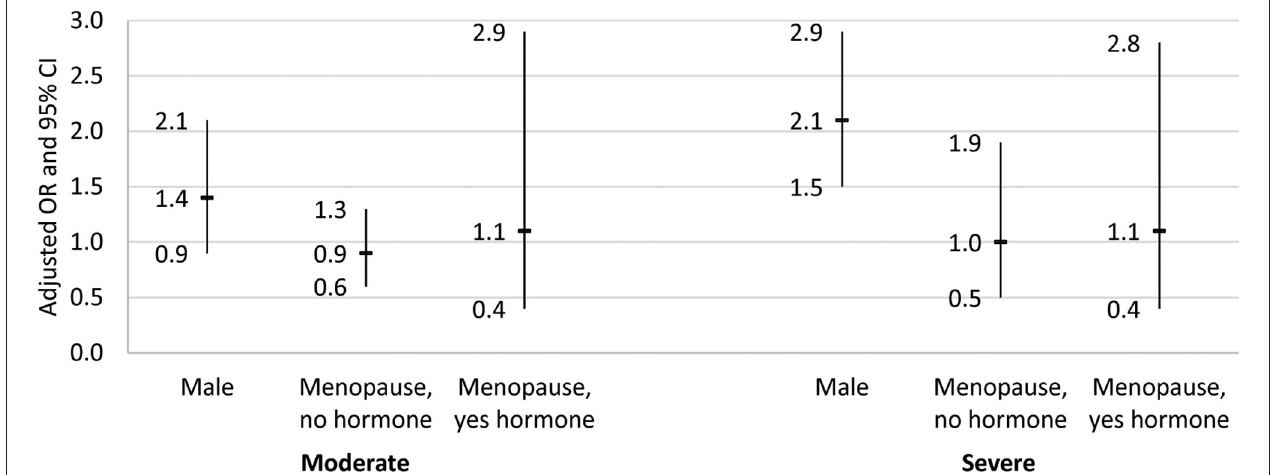
FIGURE 3 | Adjusted odds ratio and 95% confidence interval for the association between gender/menopause group and NAFLD stage. Results from the multinomial logistic regression for the association between gender/menopause group and NAFLD stage. Dash indicates odds ratio, and bar denotes the 95% confidence interval. Reference group for the dependent variable was no/mild NAFLD, and the reference group for gender/menopause was female, no menopause. Regression adjusted for demographic variables (age, race/ethnicity, education, language spoken, and poverty), physical activity status, smoking status, diet quality (healthy eating index), body composition (waist-to-hip ratio and body mass index), and laboratory values [cholesterol, HDL, triglyceride, glucose, hemoglobin A1c (HbA1c), highly-sensitive C-reactive protein (hsCRP), AST, and